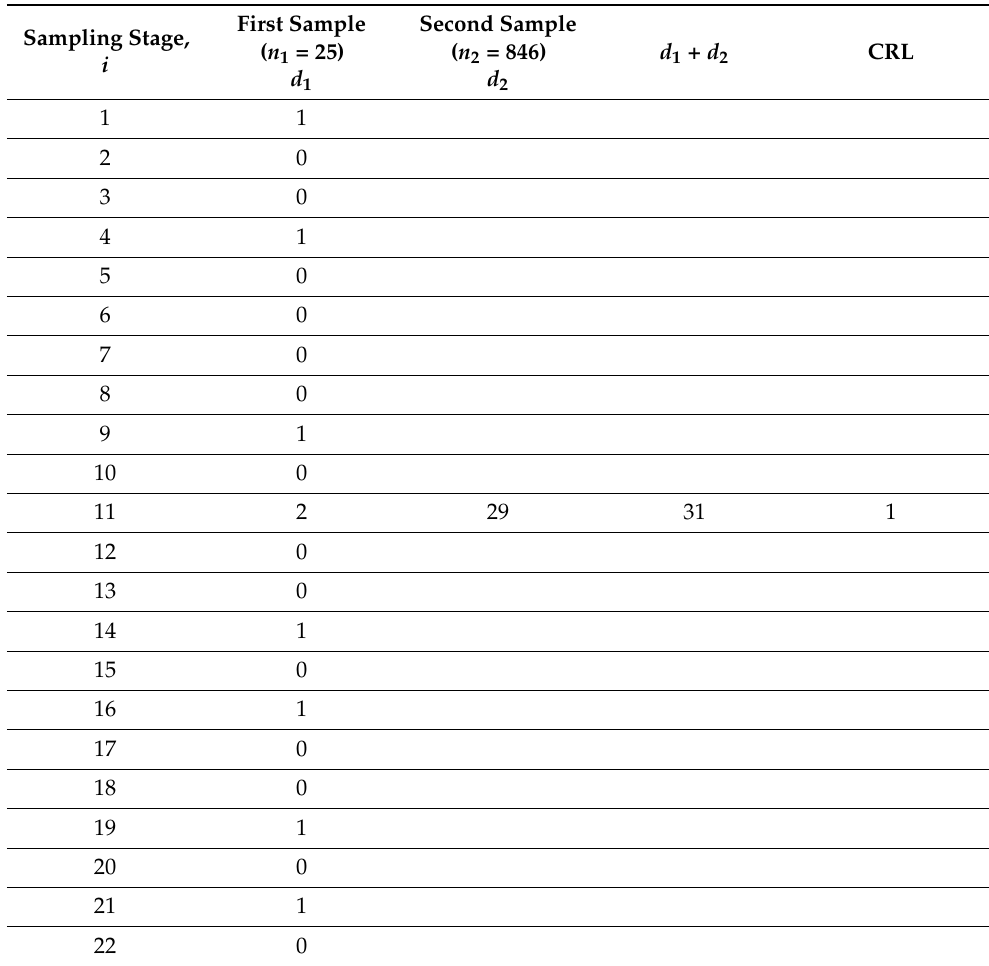
Table 8. Simulated dataset for the EMRL-based SDS np